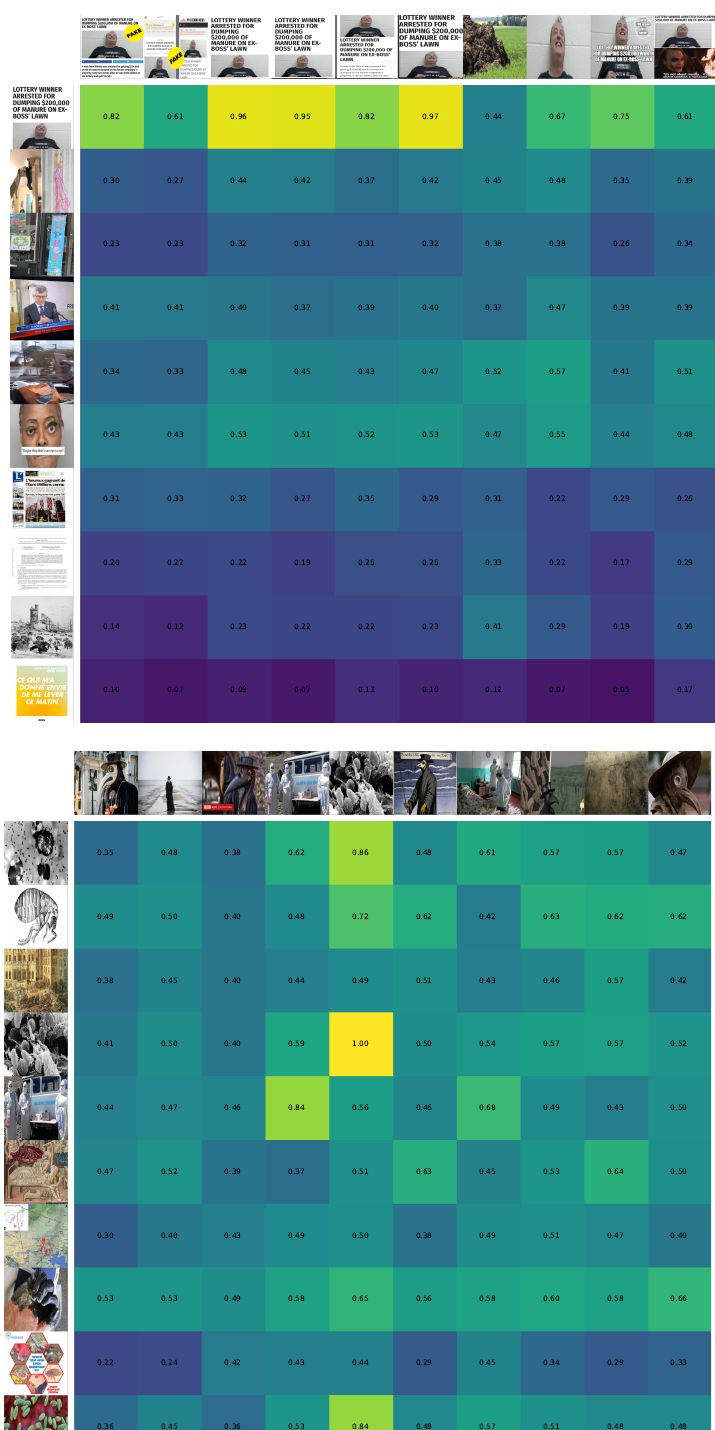
Figure 9. Examples of the pairwise image comparison with the cosine similarity for fake ( top ) and legit ( bottom ) pieces of news. The news corresponds to the two fake and true news items mentioned in the appendix, about, respectively, “lottery” and “plague”. At the top illustration, the heat map images from the English ( top row of pictures) and French ( left row of pictures) requests are compared. At the bottom —Russian and English images are